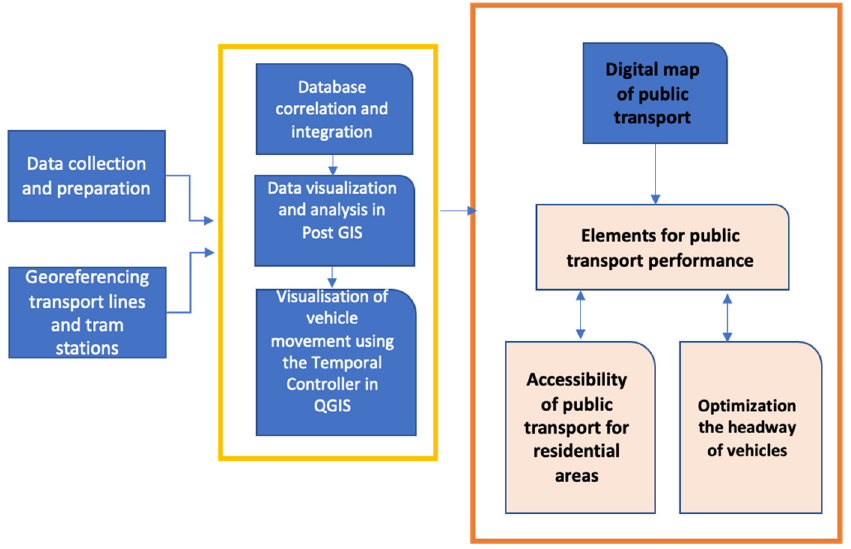
Figure 1. Logical scheme for the methodology development.